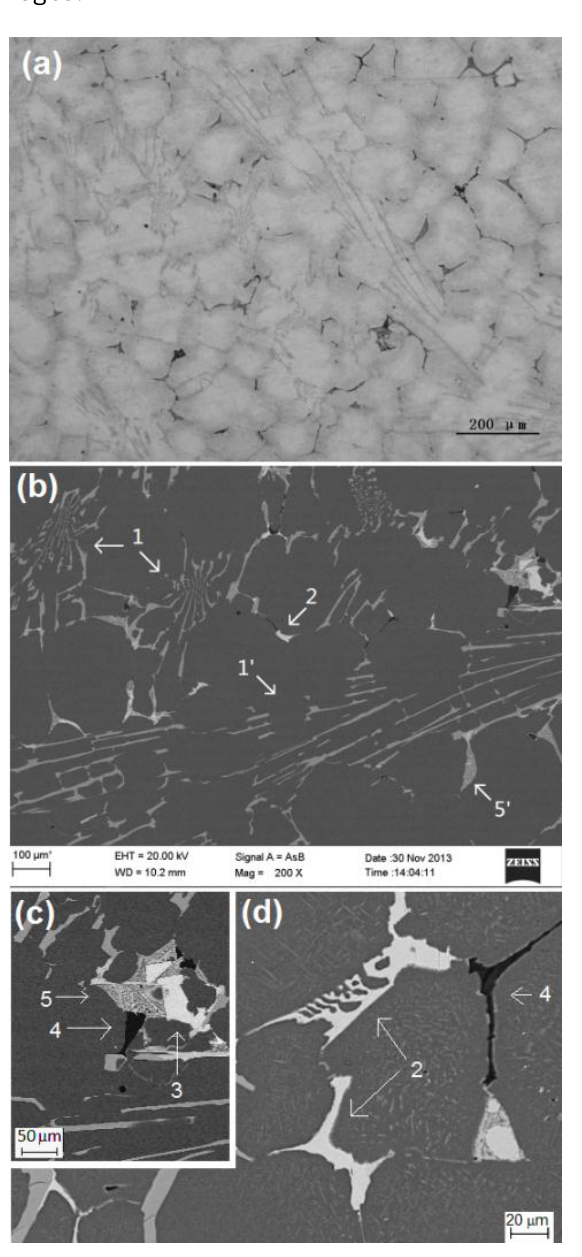
Figure 1. The as-cast microstructures of Sample FC ( a ) OM image; ( b )–( d ) SEM backscatted electron